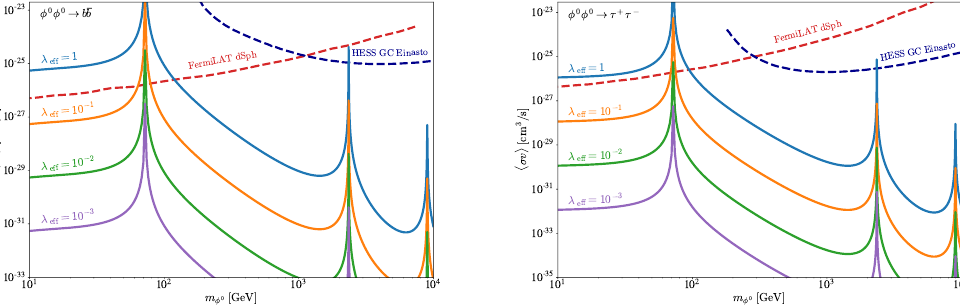
Figure 9: Annihilation cross sections for φ 0 φ 0 → bb (right panel) and φ 0 φ 0 → τ + τ − (left channel) for different values of λ as indicated. Also shown are limits on these eff channels from gamma ray observations by Fermi-LAT (red) and H.E.S.S. (dark blue).